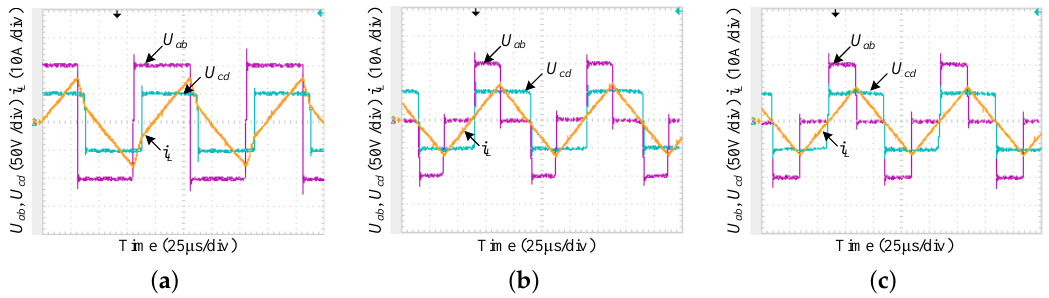
Figure 16. Experimental waveforms of DAB converter with M min = 0.04, k = 2, U 1 = 100 V, P = 300 W: ( a ) SPS scheme; ( b ) UTPS scheme; and ( c ) TPSiDT scheme.